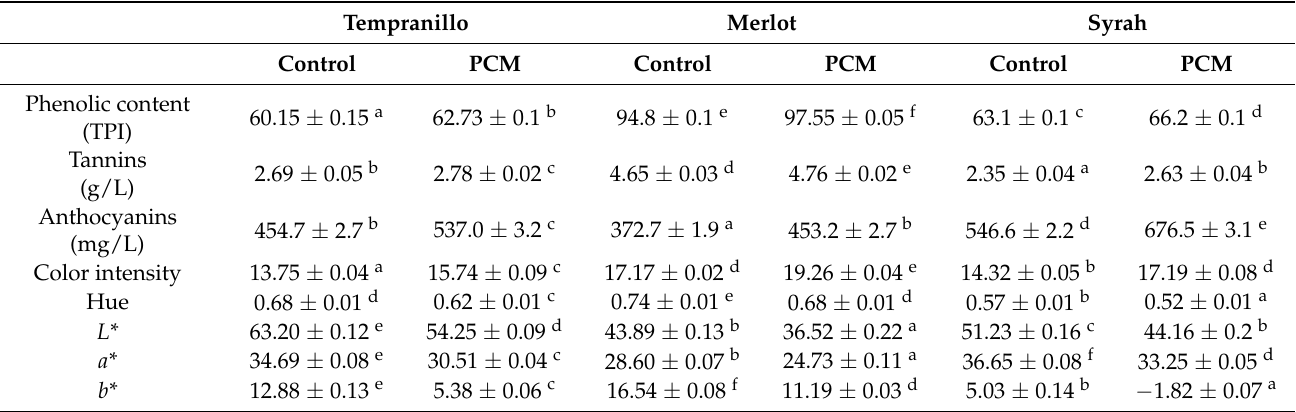
among samples ( p < 0.05) analyzed by Tukey’s multiple range test. Tempranillo Merlot Syrah PCM Control PCM Control PCM